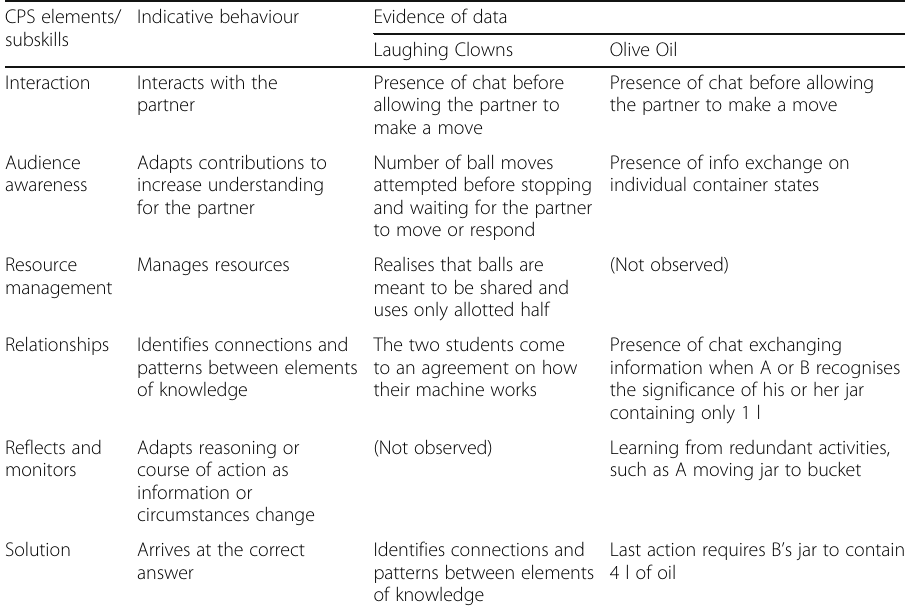
Table 2 Example of social or cognitive skills and indicative behaviours for exemplar tasks in Laughing Clowns and Olive Oil (adapted from Care et al. 2015)